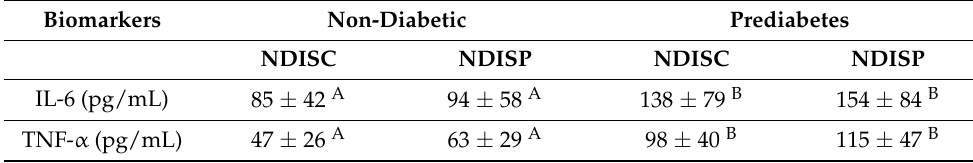
Table 4. Levels of IL-6 and TNF- α from the study groups.